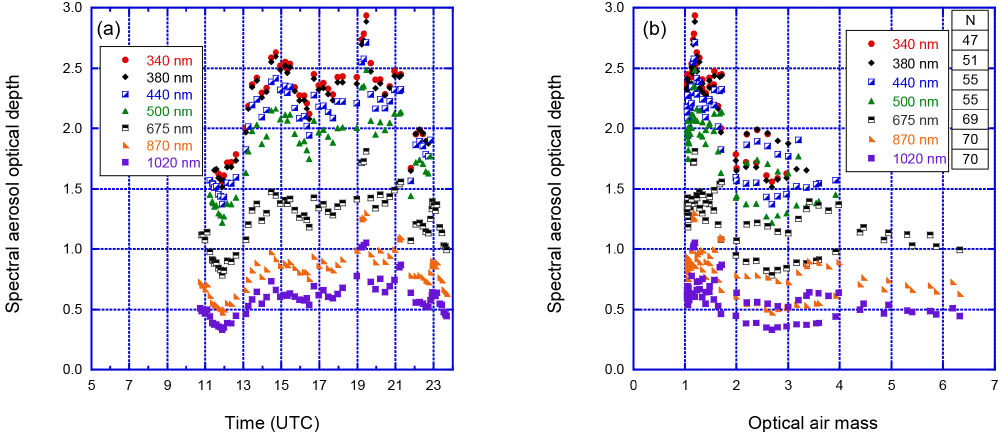
Figure 2. Spectral-dependent low digital number removal at NASA Goddard Space Flight Center (GSFC; lat 38.99, long − 76.84). (a) Level 1.0 AOD data from GSFC on 8 July 2002 are plotted for the Quebec forest fire smoke event. Significantly fewer Level 1.0 AOD data are available for the shorter wavelengths near local sunrise ( ∼ 11:00UTC) and sunset ( ∼ 23:30UTC). (b) The distribution of the AOD measurements with respect to optical air mass clearly shows the removal of short wavelengths for large air mass in this fine-mode aerosol event. The high aerosol loading due to smoke and haze results in significant extinction at UV and visible wavelengths, which corresponds to low digital counts. The low digital count quality control removes AOD measurements impacted by diffuse radiation scattered into the instrument field of view (Sinyuk et al.,